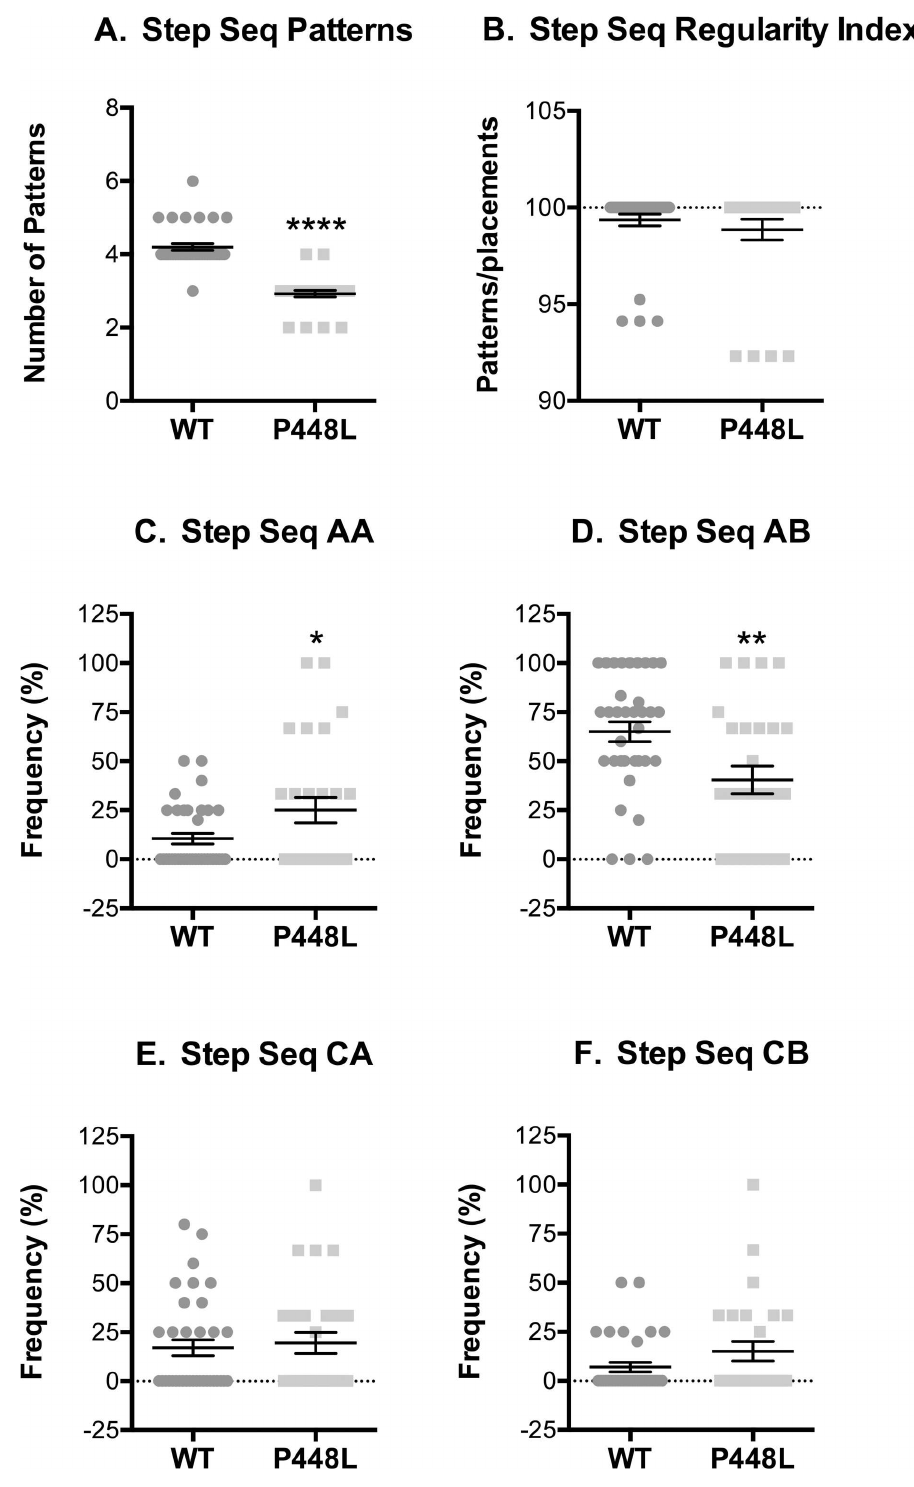
Fig 8. Stepsequence. (A) Numberof distinctstep sequencepatternsused. (B) The percentageof recognizable normalpatternsused duringa run(R, right;L, left,F, forepaw; H, hind paw; normal patterns= AA, RF-RH-LF-LH; AB, LF-RH-RF-LH; CA, RF-LF-RH-LH; CB, LF-RF-LH-RH). (C-F)Frequency of use for the indicatedpatterns.(n = 12; * p < 0.05; ** p (cid:20) 0.01, *** p (cid:20) 0.001).